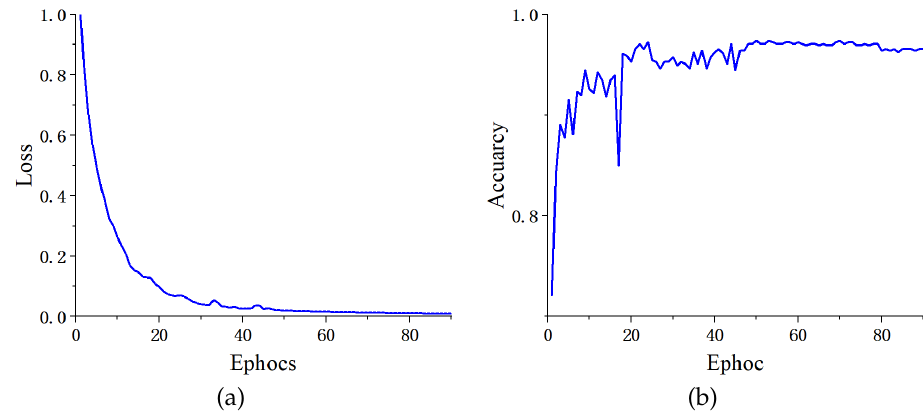
Figure 10. The curves of the training process on dataset BT-4C. ( a ) Training loss, ( b ) validation accuracy.